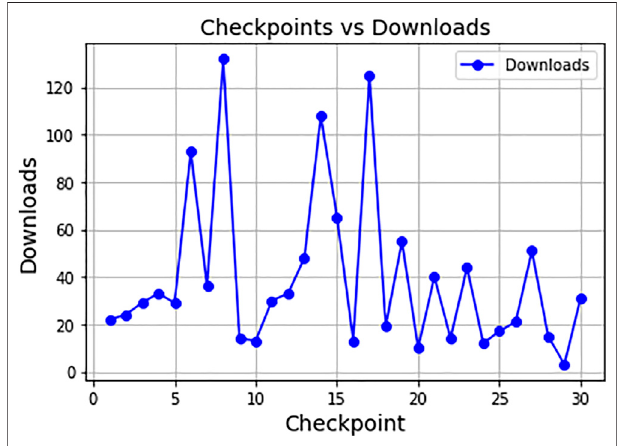
FIGURE 5 | Number of downloads at each